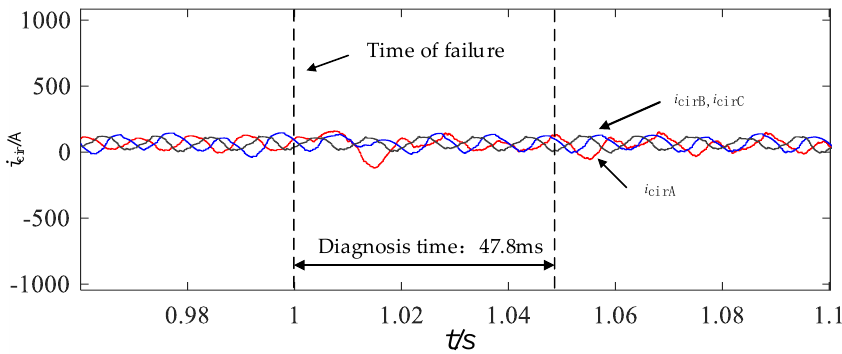
Figure 12. Simulation waveform of i cirA under SM 1 S 1 short-circuit fault. The simulation results of an open-circuit fault in the upper bridge SM 1 S 1 of phase A in a three-phase MMC system are shown in Figures 13 and 14. The S 1 open-circuit fault in the upper bridge arm SM 1 occurs at 1 s. After the fault occurs, the fault classification is completed and the open-circuit fault is located in S 1 of submodule SM 1 at 1.0762 s. The fault classification takes 47.8 ms and the determination of the fault location takes 28.4 ms.